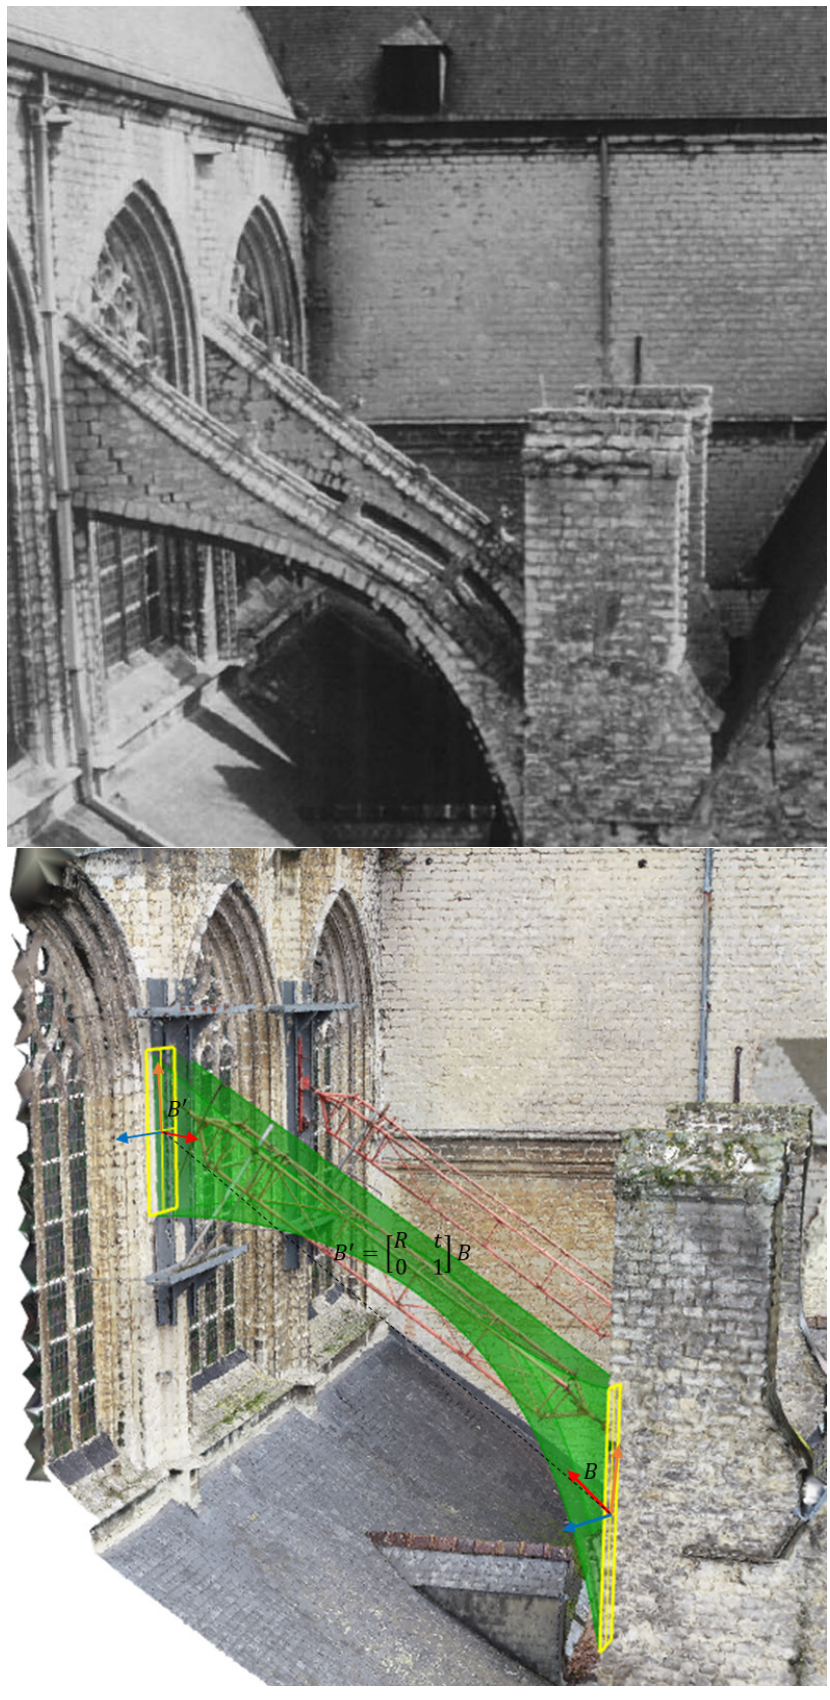
Figure 1: The upper figure shows the former flying buttresses. The existing configuration of the remaining heritage structure is shown in the bottom figure. The 3D model provides the opportunity to calculate the transformation parameters between the two surfaces B and B’, which is useful for the new design, adapted to the current